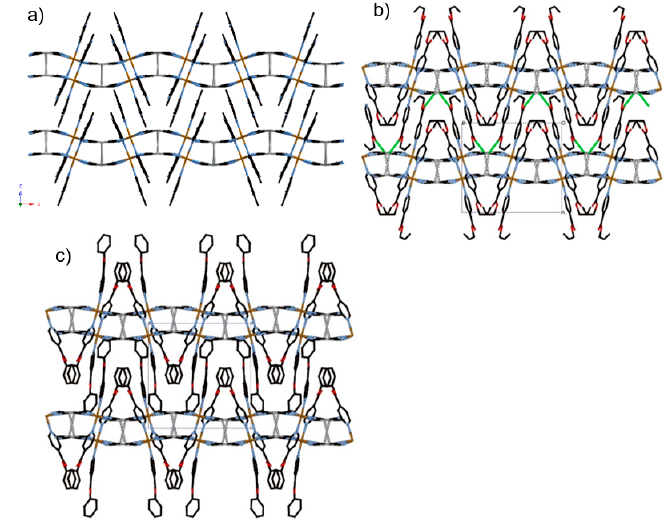
Figure 3. View of stacking layers of ( a ) 1 , ( b ) 2 , and ( c ) 3 in HS state involved in Ag··Ag interactions, as indicated by grey lines, and Ag···O interactions, as indicated by green lines.